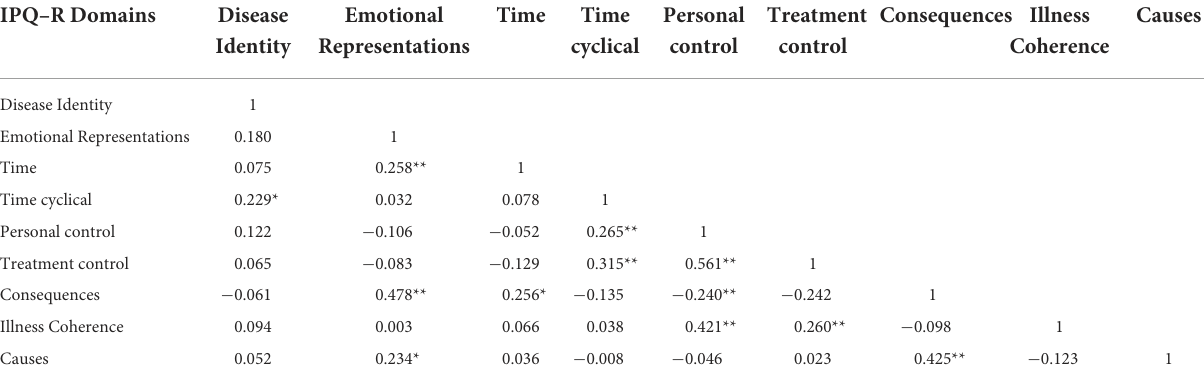
TABLE 3 Inter–Correlation between subscales of the IPQ–R ( n = 100). IPQ–R